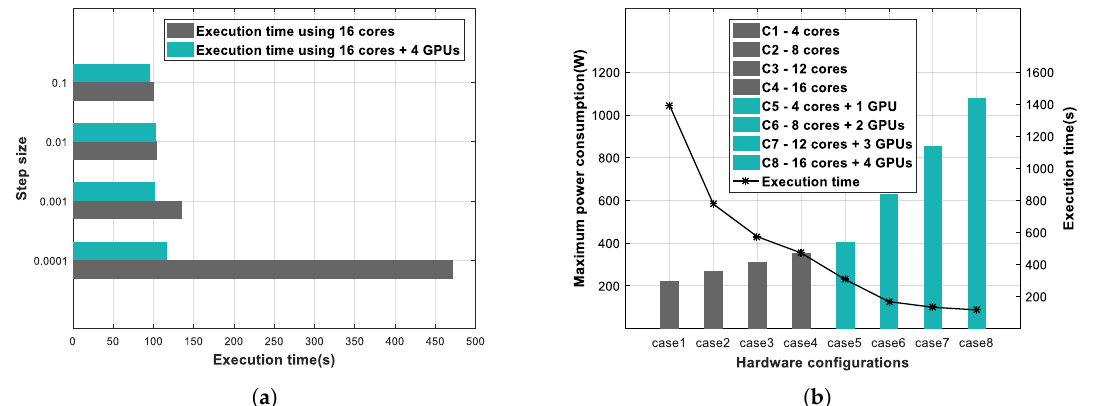
Figure 11. ( a ) Execution time of simulation according to the step size of differential equations; ( b ) maximum power consumption according to the hardware configurations.